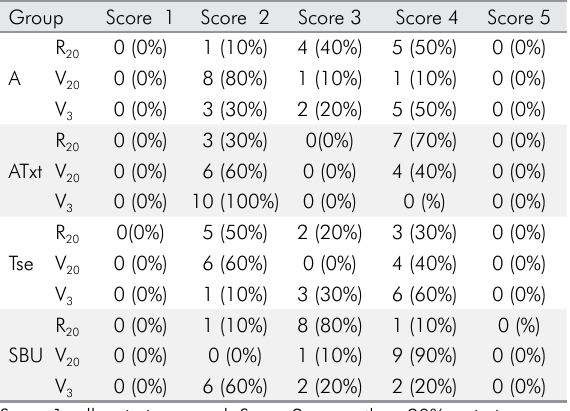
Score 1: all resin in enamel, Score 2: more than 90% resin in enamel, Score 3: between 10% and 90% resin in enamel, Score 4: less than 10% resin in enamel, Score 5: no resin in the enamel.